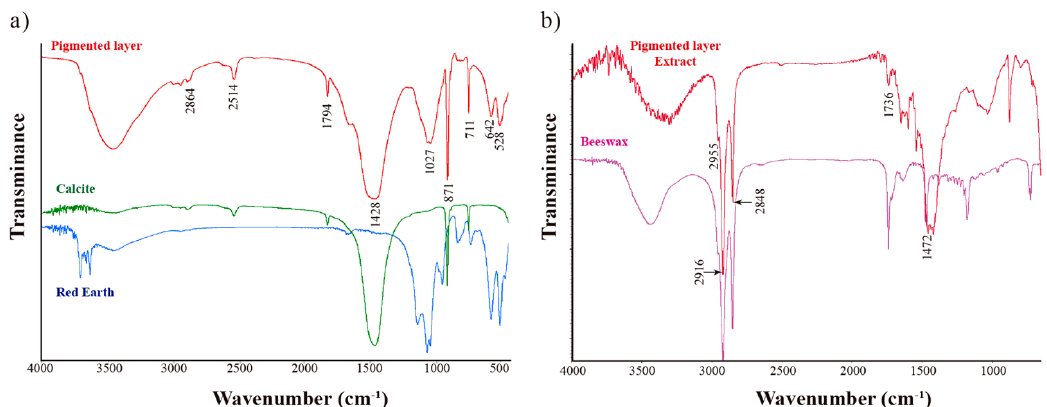
Figure 9. Fourier transform infrared spectroscopy (FTIR) analysis of the pigmented layer of the cistern plaster. ( a ) FTIR spectra showing the highest intensities bands of calcite and hematite (red earth). ( b ) FTIR spectra showing the highest intensities bands of the organic compound identified as beeswax. Calcite bands at 2864 cm − 1 , 2514 cm − 1 , 1794 cm − 1 , 1428 cm − 1 , 871 cm − 1 , and 711 cm − 1 ; hematite (red earth) bands at 1027 cm − 1 , 642 cm − 1 , and 528 cm − 1 . Beeswax bands at 2955 cm − 1 , 2916 cm − 1 , 2848 cm − 1 , 1736 cm − 1 , and 1472 cm − 1 .